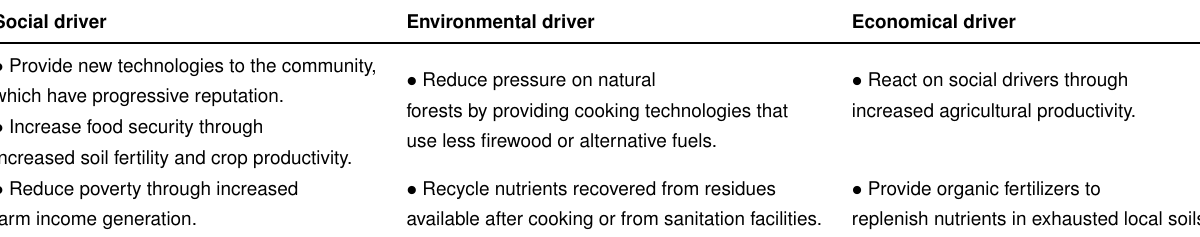
Table 1. Definition of driving forces behind the technology development of case study projects. These definitions had been pre-formulated by the planner and were then proofed and agreed on by participants during the design process. Social driver